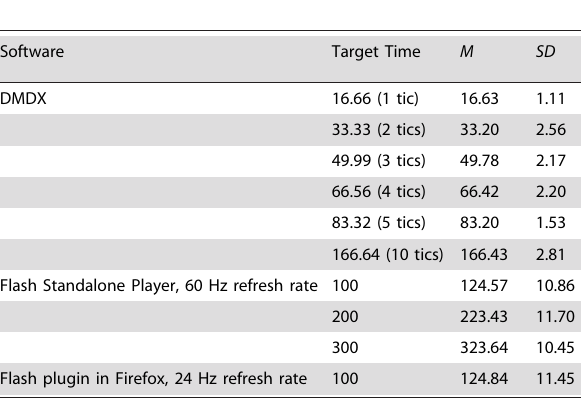
Table 4. Presentation times by DMDX and ScriptingRT (in ms, Study